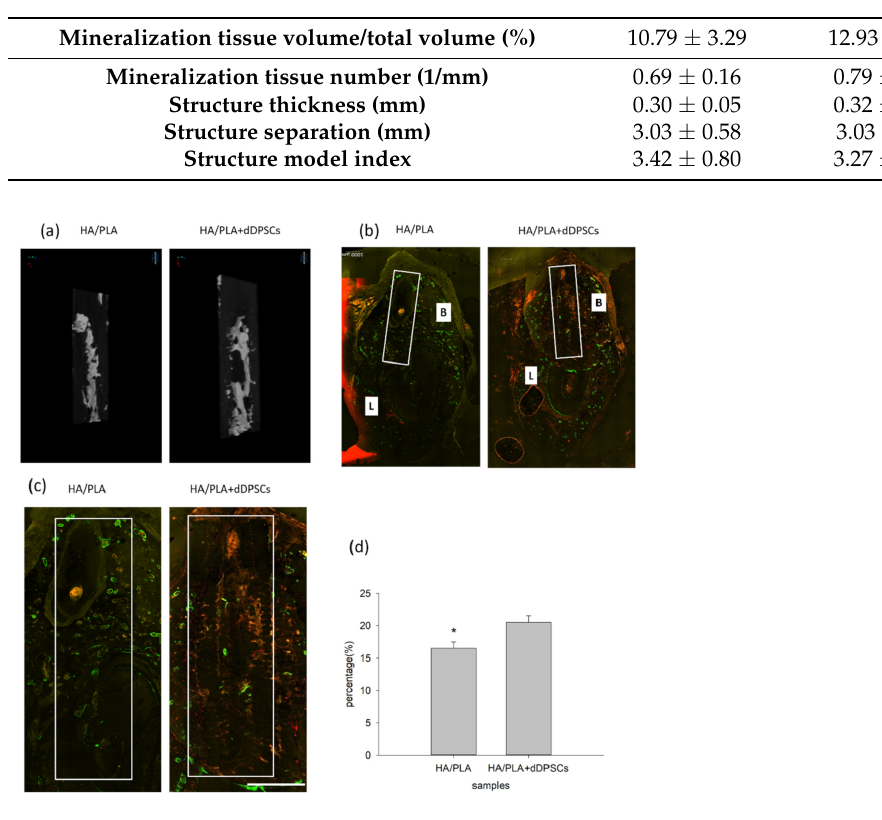
Figure 6. Micro-CT and merged confocal microscope images at 40 weeks. ( a ) 3D reconstruction micro-CT images of new formation mineralization zone. ( b ) Mesiodistal section view of merged confocal microscope images. The rectangle zone indicated the 3D-print HA/PLA scaffolds area. At week 40, the 3D-print HA/PLA plus dDPSCs group showed higher fluorescence intensity and more red fluorescence incorporation, which indicated tissue mineralization occurred at the defect zones. Scale bar: 1000 µ m. ( c ) The higher magnification of the fluorochrome area at defect zones (white boxes) areas. Scale bar: 2 mm. ( d ) The percentage of fluorochrome area was calculated at defect zones (white boxes areas in the draw). * p <